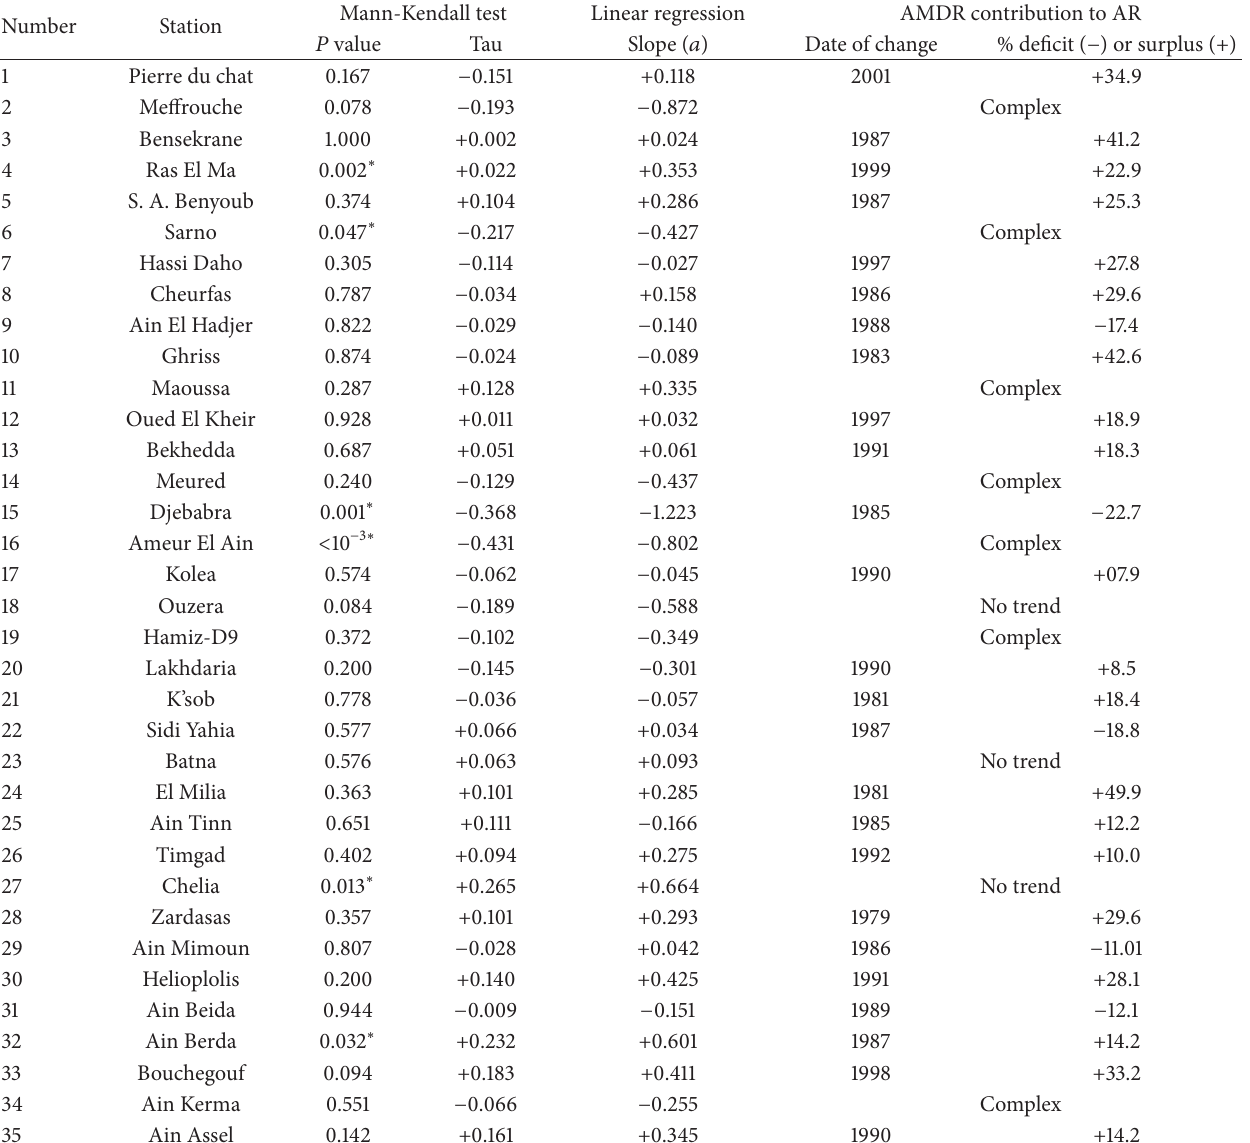
Table 2: 𝑃 values and Tau of Mann-Kendall test, the slope ( 𝑎 ) of linear regression analysis, and AMDR contribution to AR over the period after 1970 in the north of